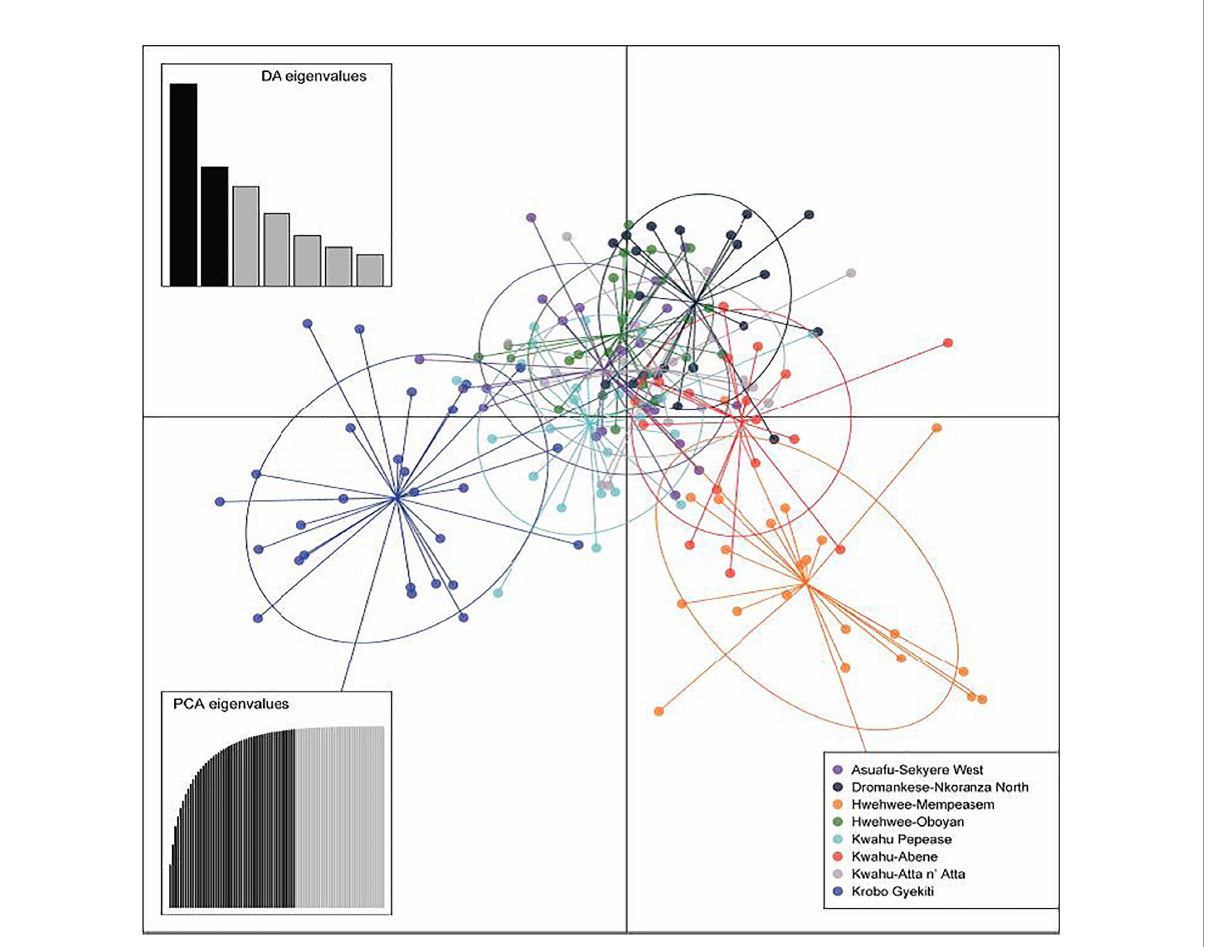
FIGURE 4 Discriminant Analysis of Principal Components (DAPC) plot of Cryptolepis sanguinolenta individuals across eight subpopulations in Ghana. Data was constructed using 1,000 permutations. Discriminant Analysis eigenvalues are also